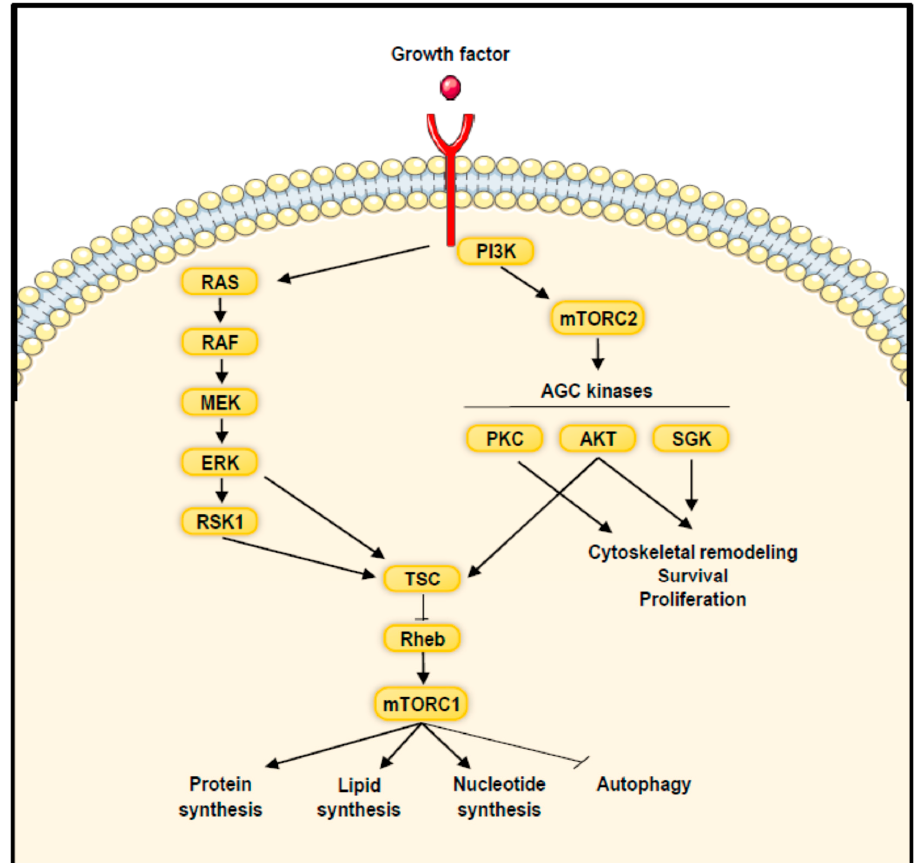
Figure 3. Activation of mTOR signalling pathway by growth factors. Upon stimulation of growth factor receptors, mTORC1 is activated via the PI3K/AKT and Ras/Raf/Mek/Erk signalling pathways and stimulates anabolic processes and represses autophagy. mTORC2 activation requires PI3K. Once activated mTORC2 regulates cytoskeletal organization, cell proliferation and survival by phosphorylating members of the AGC kinases family.